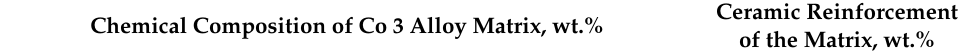
Table 2. Chemical composition of Co3+TiC+PD-W powder. Chemical Composition of Co 3 Alloy Matrix, wt.%